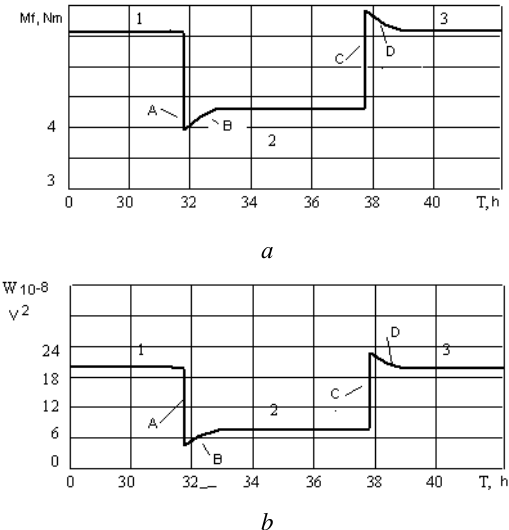
Fig 1. Associations of М f ( а ) and average power signals W from time (friction pairs without MCL). Value of applied load- ing: “1.3,” – σ max =1000 М P а ; 2 – σ max =600 М P а